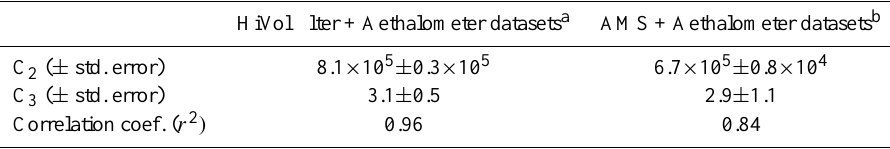
Table 4. Fitting of the Aethalometer model C 2 and C 3 parameters, using the two different carbonaceous aerosol datasets (see Eq. 5, α ff =1.0, α wb =2.0 , and C 1 =2.6 × 10 5